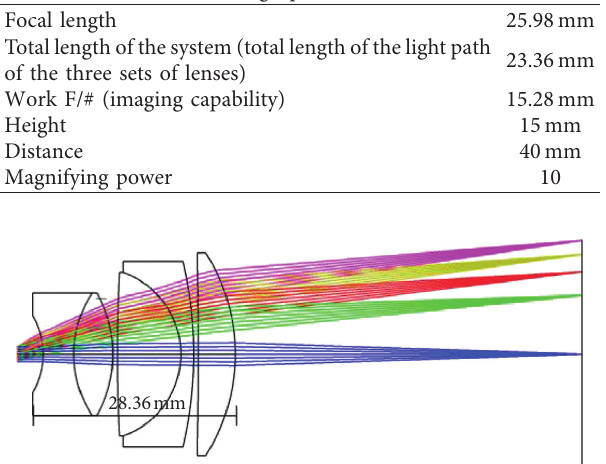
Table 1: Main design parameters of microlens.